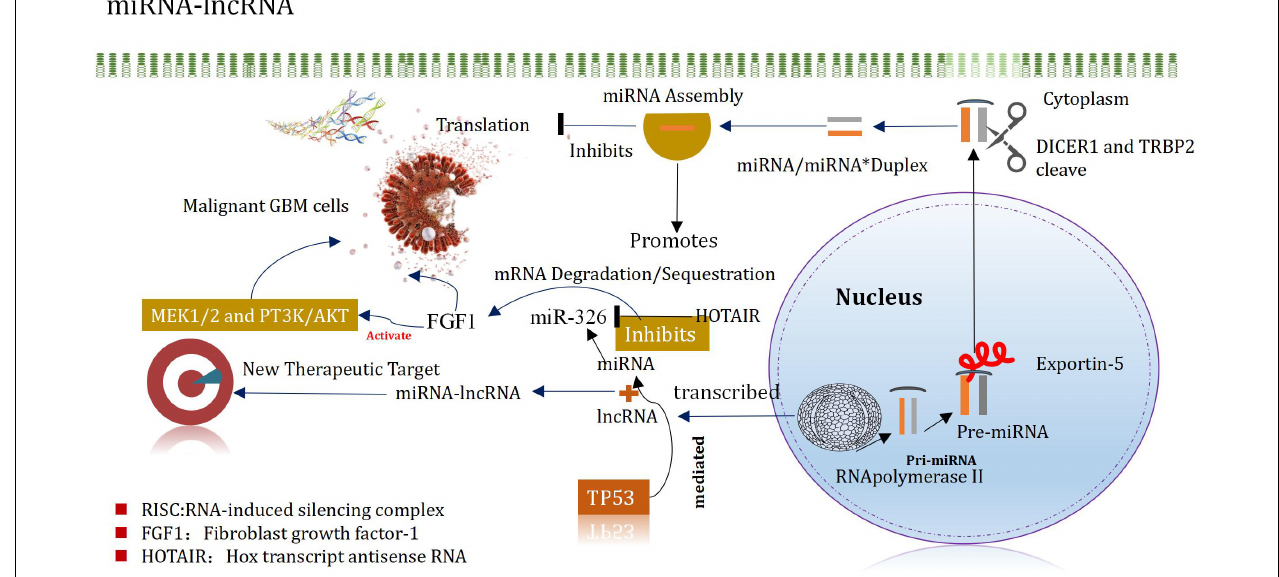
FIGURE 4 | Interaction of miRNA and lncRNA in